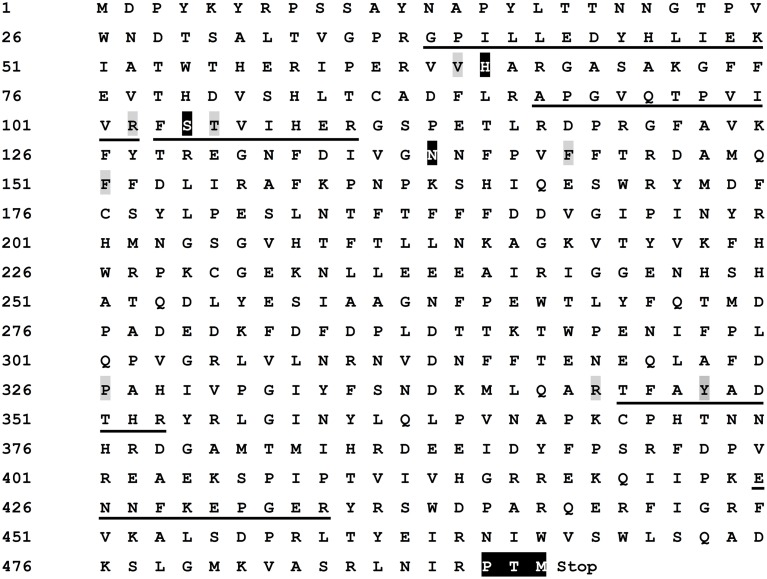
Characterization of deduced amino acid sequence of cloned cDNA. The amino acid sequences identical to the peptide fragments determined by nano-LC-MS/MS were underlined. The conserved catalase catalytic amino acid residues (active site), 65-H (His), 104-S (Ser), and 138-N (Asn), were white and black-marked. The distal heme binding domain [64-V (Val), 102-R (Arg), 105-T (Thr), 143-F (Phe), and 151-F] and proximal heme binding domain [326-P (Pro), 344-R, and 348-Y (Tyr)] were gray-marked. A putative conserved internal peroxisomal targeting signal (PTM) was in white and black at the C-terminal [490-P, 491-T, and 492-M (Met)]. The stop signal was represented by “Stop”. The sequence has been deposited in GenBank as Accession No. KP710221.